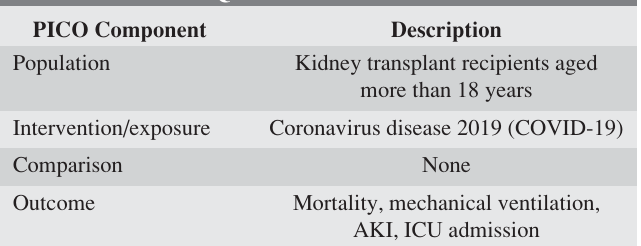
Table 1. Research